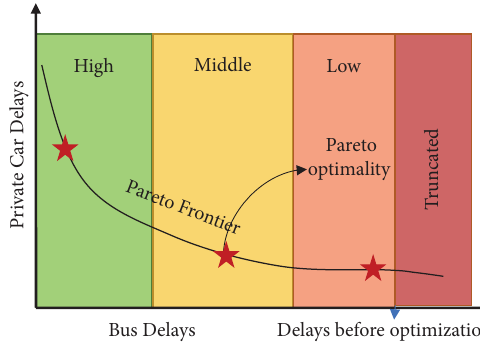
Figure 7: Diagram of decision making.